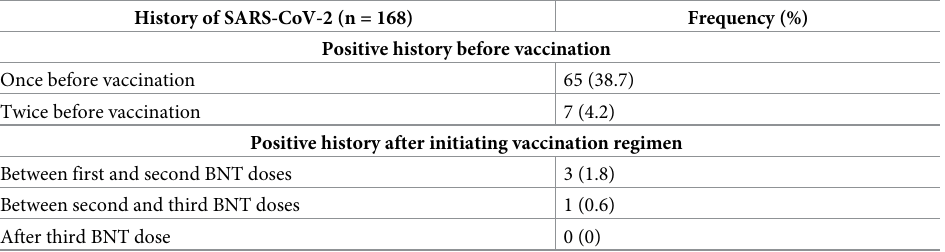
Table 2. History of SARS-CoV-2 infection.